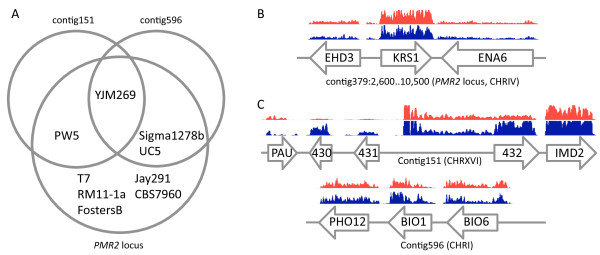
Occurrence analysis of three regions present in the CEN.PK113-7D genome, but not in the S288C genome. A) Venn diagram that represents the occurrence of the three regions over the available S. cerevisiae sequenced strains in Genbank (Additional file 12: Table S7). B and C) Annotation of the regions and RNA-seq expression profiles. RNA-seq data from glucose- and nitrogen limited anaerobic chemostat cultures (red and blue, respectively) were plotted (one bar every 10th base) for the CEN.PK113-7D specific ENA locus (B) and the two specific contigs (C). Expression data, expressed as the number of times a base is covered by a read, are ranged from are [0-750] for contig379 and contig151 and [0-250] for contig596.